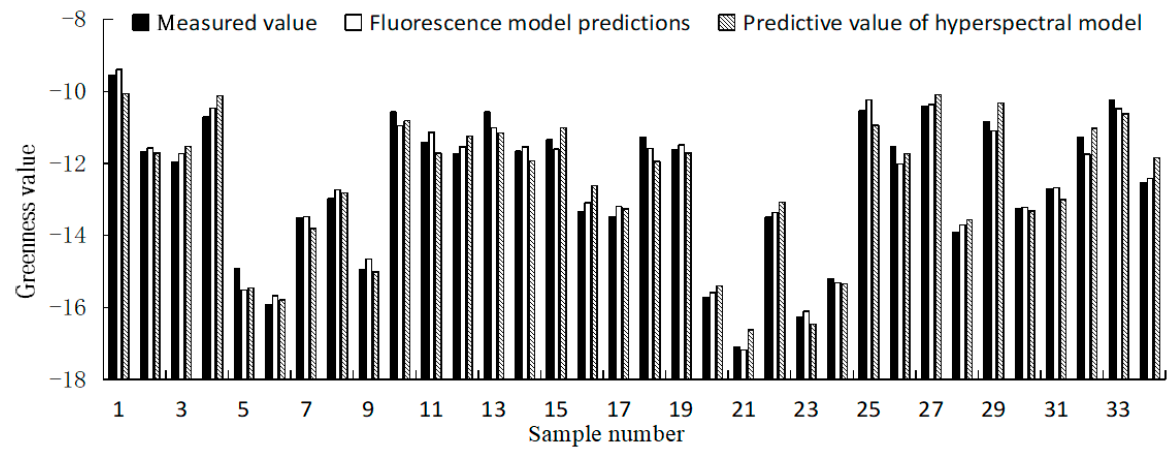
Figure 6. Contrast diagram of the prediction results of the greenness value. The scatter plots of the residual distribution of the predicted greenness values of tomato leaves based on the fluorescence spectrum and hyperspectrum are shown in Figure 7. The residual difference between the measured greenness value and the predicted greenness value was low based on the fluorescence spectrum and hyperspectrum of tomato leaves. The residual values of more than 90% of the samples were between ±0.3 and ±0.5, and the distribution of residual points was relatively uniform [20]. These two points of analysis, combined with the previous R 2 and RMSEP analysis, demonstrated that the pre- diction accuracy of the model for the tomato leaf greenness value based on the fluores- cence spectrum and hyperspectrum was high, and the prediction results met the require- ments. ( a ) ( b ) Figure 7. ( a ) The residual distribution map of greenness value for predicted samples based on fluo- rescence spectral model; ( b ) the residual distribution map of greenness value for predicted samples based on hyperspectral model. 3.3. Comparison of Models for the Prediction of Photosynthetic Rate The two kinds of spectra were established using the regression model of the photo- synthetic rate, and the linear scatter plots of the predicted and measured values of the photosynthetic rate of the tomato leaf inspection set based on the two spectral technolo- gies were obtained (Figure 8). The R 2 of the model based on the fluorescence spectral model (0.9928) was higher than that of the hyperspectral model (0.9739), while the RMSEP of the former (0.2781) was smaller than that of the latter (0.3374), which meant that the fluorescence spectral model had a higher detection accuracy with lower deviations than the hyperspectral model.